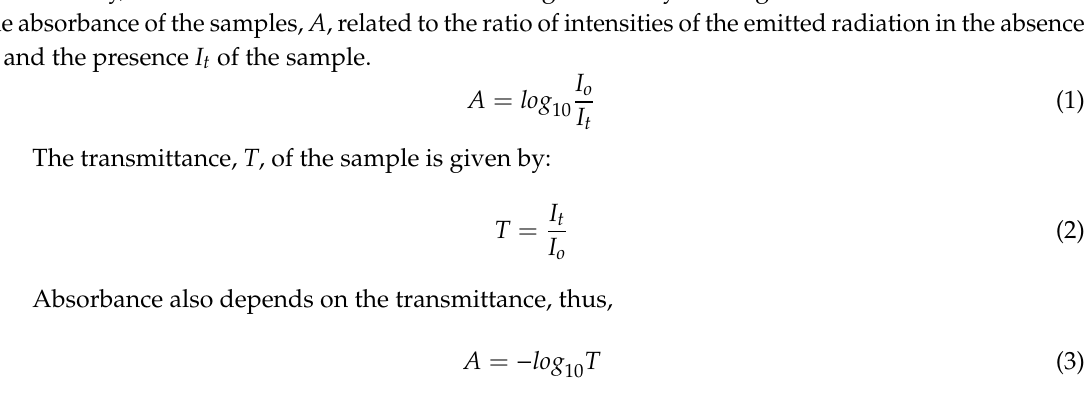
Figure 8. Absorbance spectrum of CTAB, HGQDs, and CTAB/HGQDs thin films.